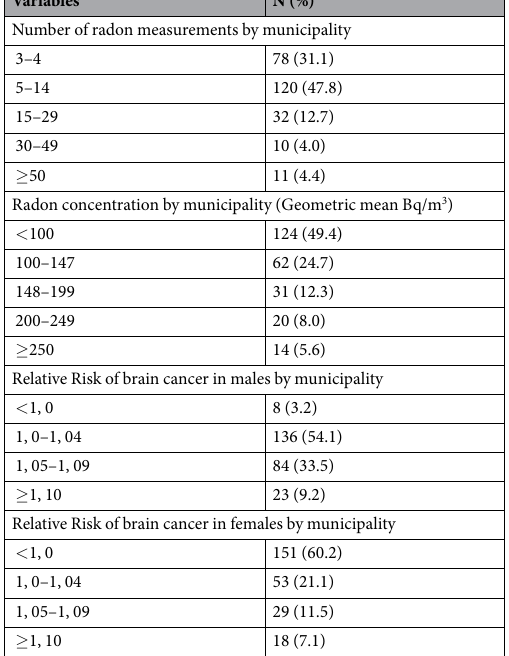
Table 1. Characteristics of residential radon measurements and risk of brain cancer in the included